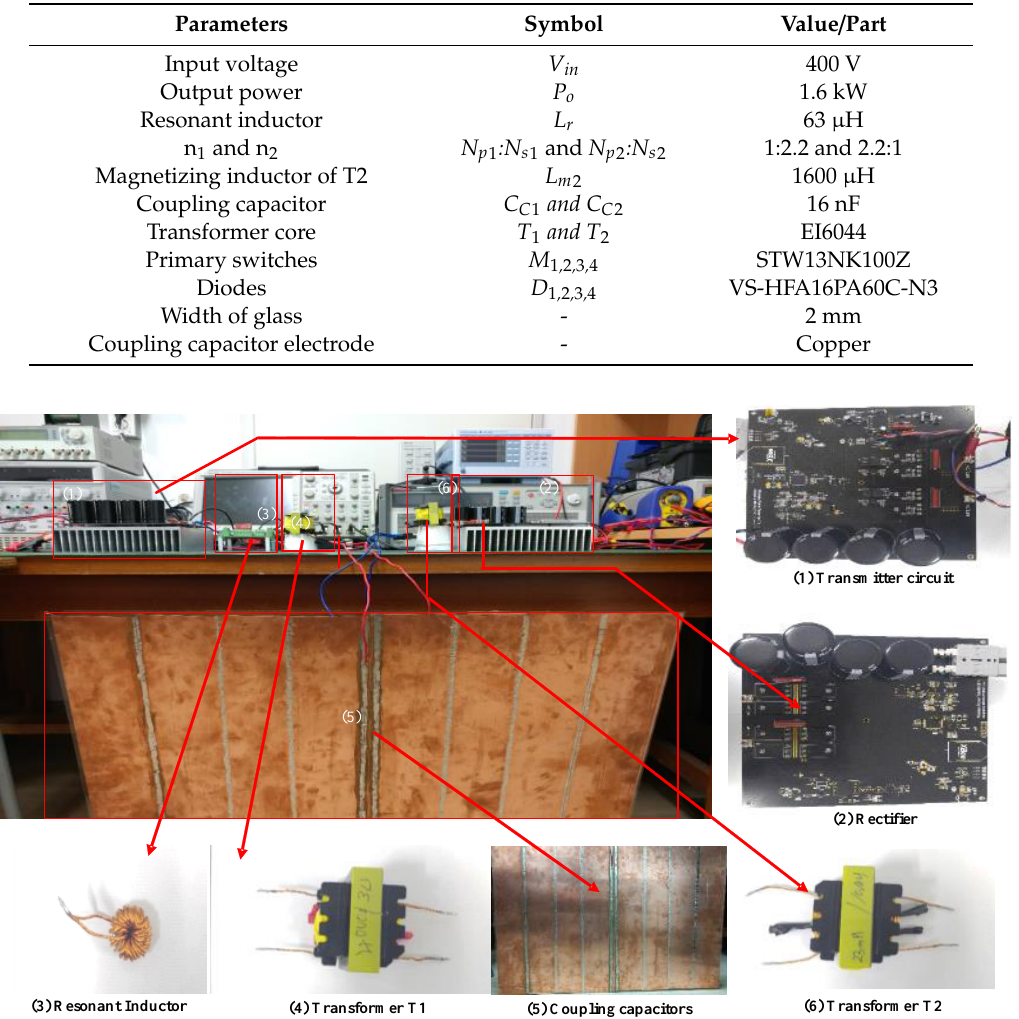
Figure 9. Experimental set: transmitter circuit, rectifier, the resonant inductor, two transformers, the coupling capacitors using glass and copper plate.